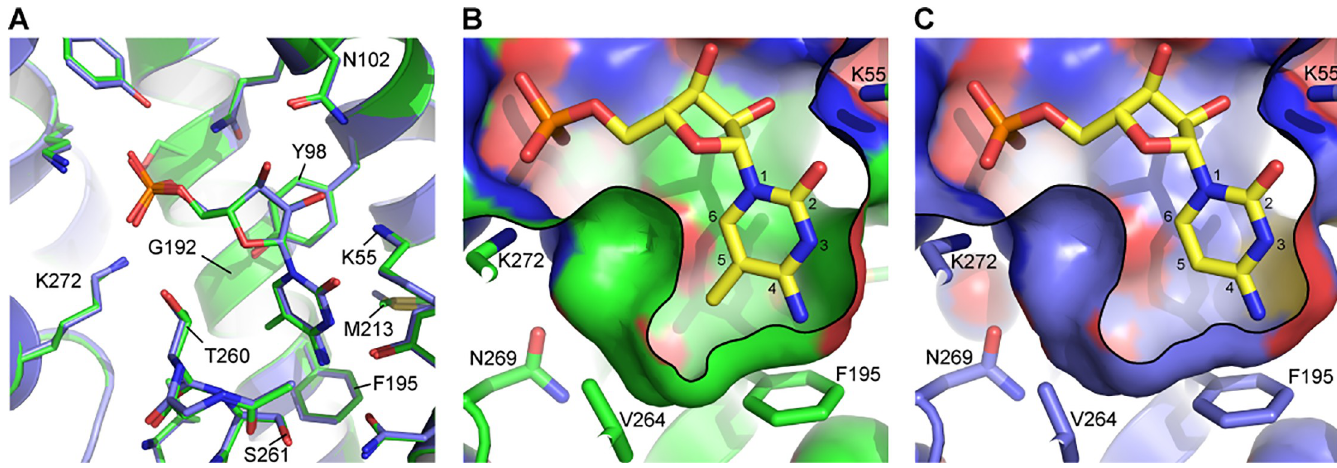
Fig 5. Comparison of the m 5 CMP and CMP binding sites. A) A close-up of the substrate binding pocket is shown for both the CST-m 5 CMP (green) and CST-CMP (blue) structures. Only substrate-interacting side chains are shown and portions of TM8 are hidden for clarity. B and C) A slice through the surface representation of the substrate-binding cavity is shown for the CST-m 5 CMP (B) and CST-CMP (C) structures. The atoms for the pyrimidine ring are numbered. A black line is added as a visual aide to indicate where the cavity volume was sliced. The view is similar to that shown in panel A but is adjusted slightly to better show the part of the substrate- binding cavity that interacts with the C-5